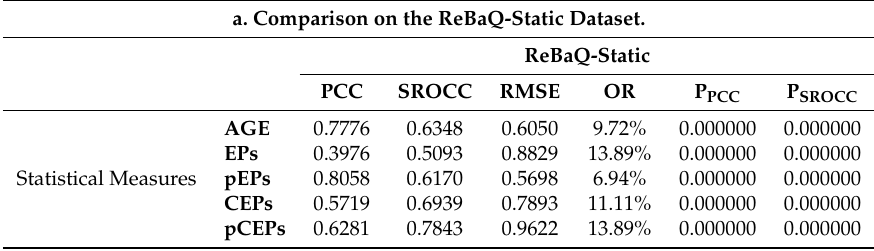
Table 1. Comparison of RBQI vs. Statistical measures and IQA techniques on the ReBaQ dataset. a. Comparison on the ReBaQ-Static